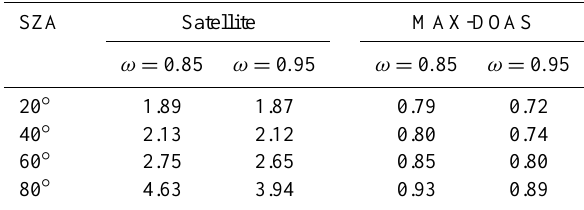
Table 7. Shielding factors, i.e. the ratio of “true” and approximately estimated tropospheric NO 2 VCD, for satellite and ground-based MAX-DOAS observations, calculated for the same environmental conditions as shown in Fig. 17, at AOD = 1.